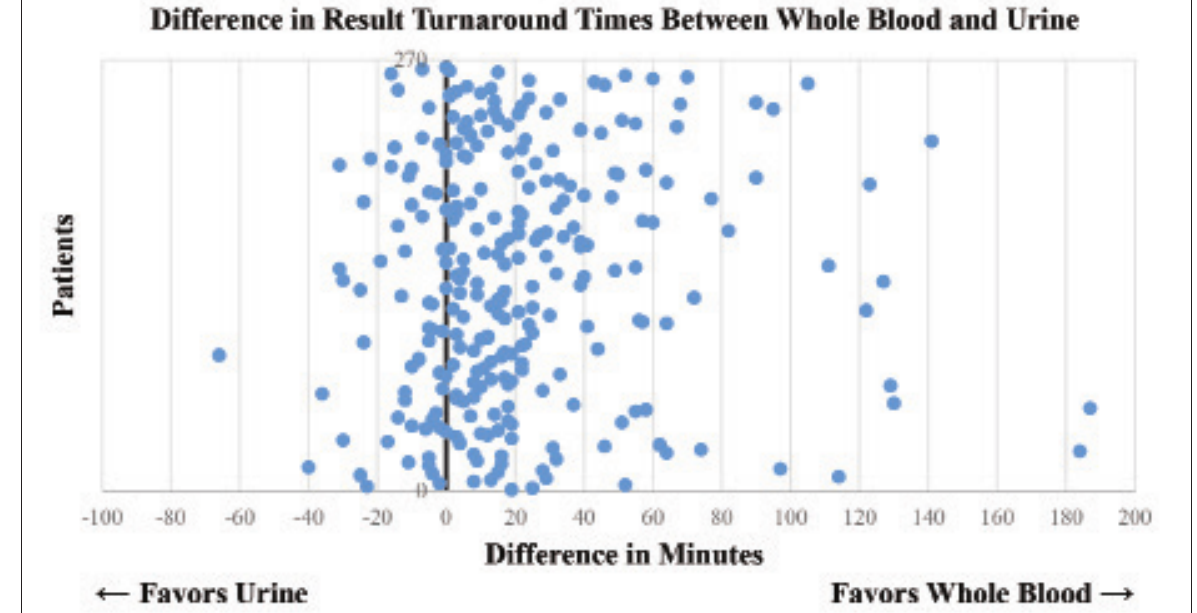
Figure 2. Scatter plot demonstrating the differences in the turnaround time between whole blood and urine pregnancy